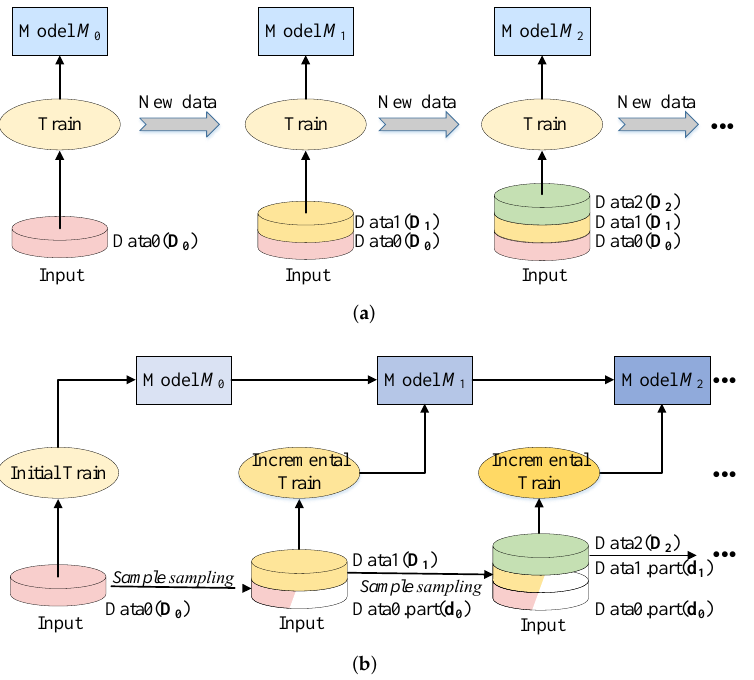
Figure 1. Illustration of the non-incremental learning and incremental learning process. ( a ) Non- incremental learning (batch learning) process. ( b ) Incremental learning